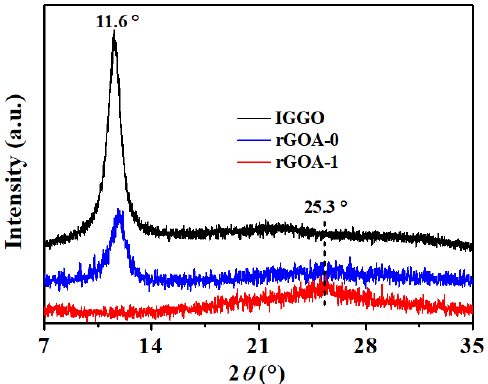
Figure 3. X-ray diffraction (XRD) patterns of IGGO, rGOA-0, and rGOA-1.